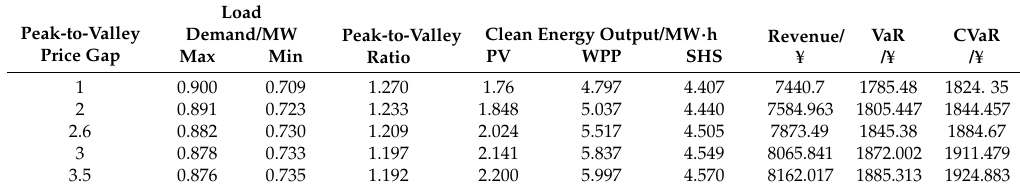
Table 6. Scheduling results of VPP operation in different peak-to-valley price gaps.